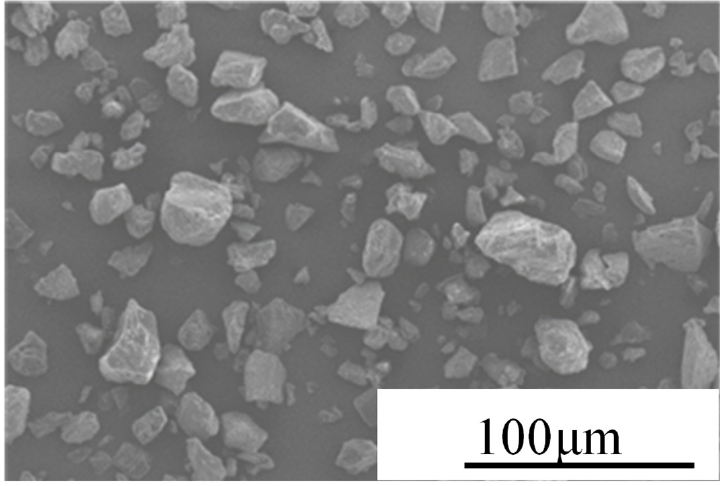
Figure 2. SEM image of fine polyurethane powder (D 50 = 22 μ m).